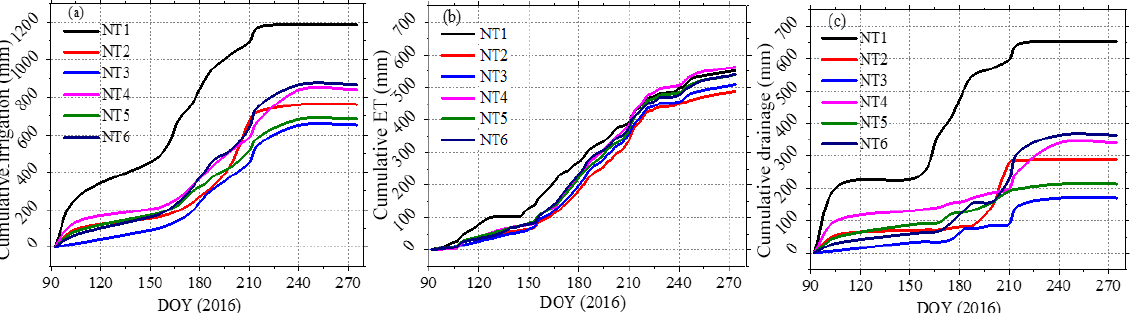
Figure 7. Estimated water components of the plots during the growing season of 2016: (a) cumulative irrigation, (b) cumulative ET, and (c) cumulative drainage. Note: DOY refers to day of year. Table 4. Estimated evapotranspiration and other major soil water balance components during the growing season of 2016. Cumulative SWBCs NT1 NT2 NT3 NT4 NT5 NT6 Irrigation (in mm) 1186.5 760.1 Drainage (slow drainage; in mm) 651.8 (62.4) Evapotranspiration (in mm) Storage diff. ∗ (in mm) ∗ Storage differences represent the difference in soil water storage before and after the growing season.